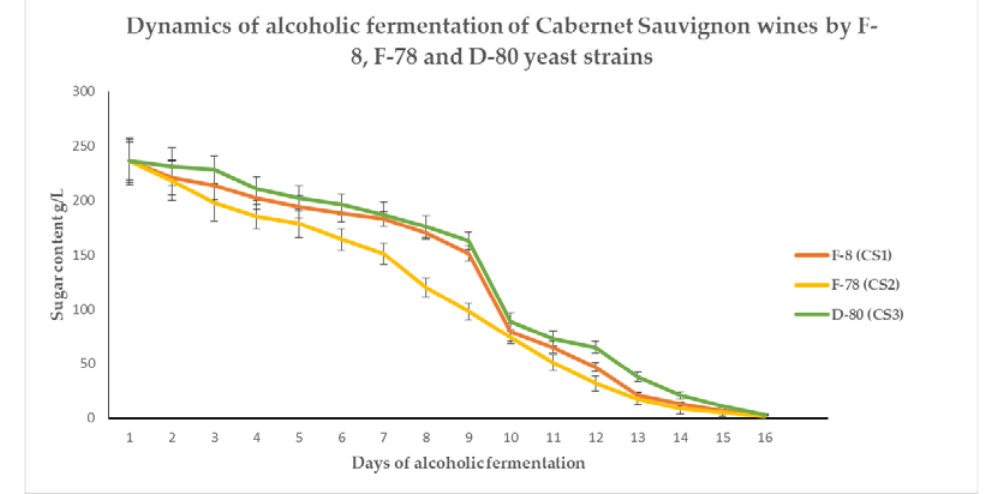
Figure 2. Dynamics of the alcoholic fermentation of Cabernet Sauvignon wines produced by autochthonous and commercial yeast strains through the screening of the total amount of reducing sugars. The results refer to the mean values and standard deviations (mean ± STDV), expressed as g/L. Mean ± STDV were calculated from one replicate of each fermentation type (see Table 1) and four analytical measurements. Wine type abbreviations are defined in Table